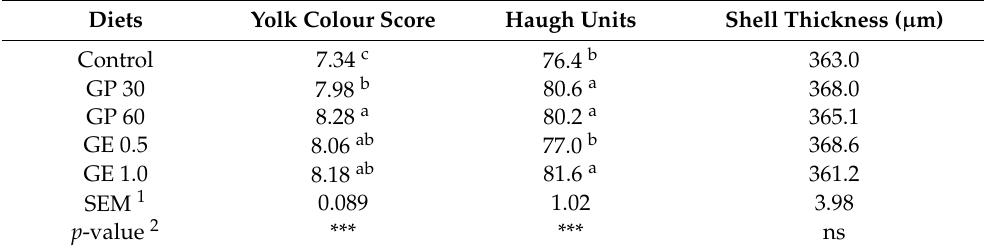
Table 5. Effect of grape pomace (GP) and grape extract (GE) at different dietary concentrations (g/kg) on yolk colour score, Haugh units of the albumen and shell thickness in eggs of 50- to 54-week-old laying hens.